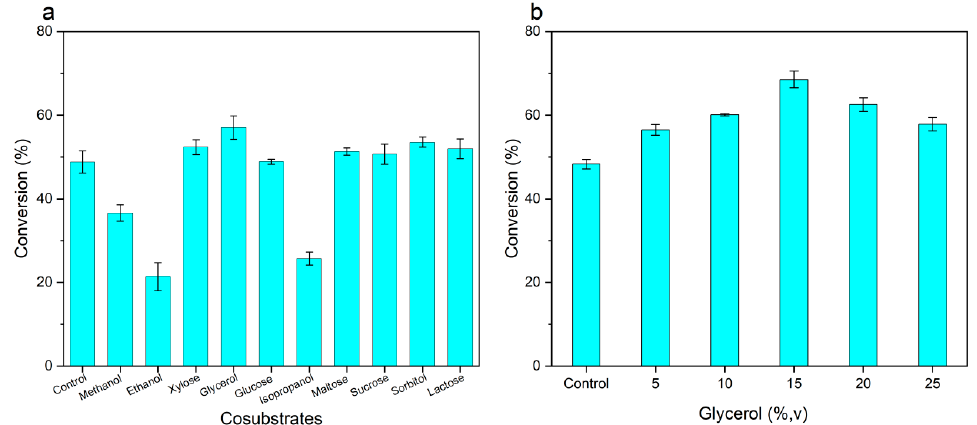
Figure 6. The effect of cosubstrates on the TQ-2 whole cell catalyzed acetophenone reduction. The general reaction conditions used otherwise stated: 2 mM of substrate, 0.1 g/mL of microbial cells, 5 mL of phosphate buffer (100 mM, pH 7.0), and 600 rpm for 48 h; ( a ) 10 mM of each solid cosubstrates or 5% ( v/v ) of each liquid cosubstrates were added; ( b ) glycerol was added with a different final concentration (1–25%, v/v ). Error bars indicate standard deviation.